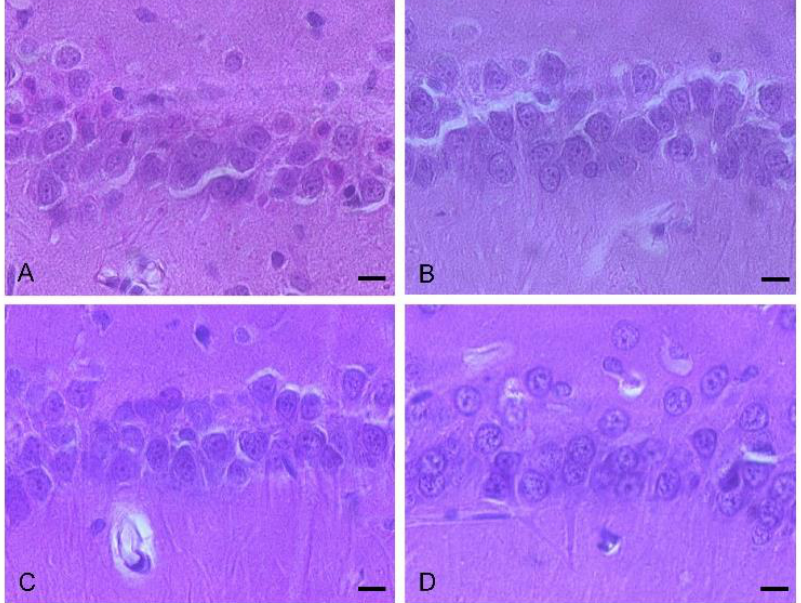
Figure 4. Hippocampal cell counts of ( A ) sham conditioning (n = 9), ( B ) true conditioning (n = 9), ( C ) vehicle (n = 9) and ( D ) resveratrol conditioning groups (n = 7) (bar length is 10 µm).